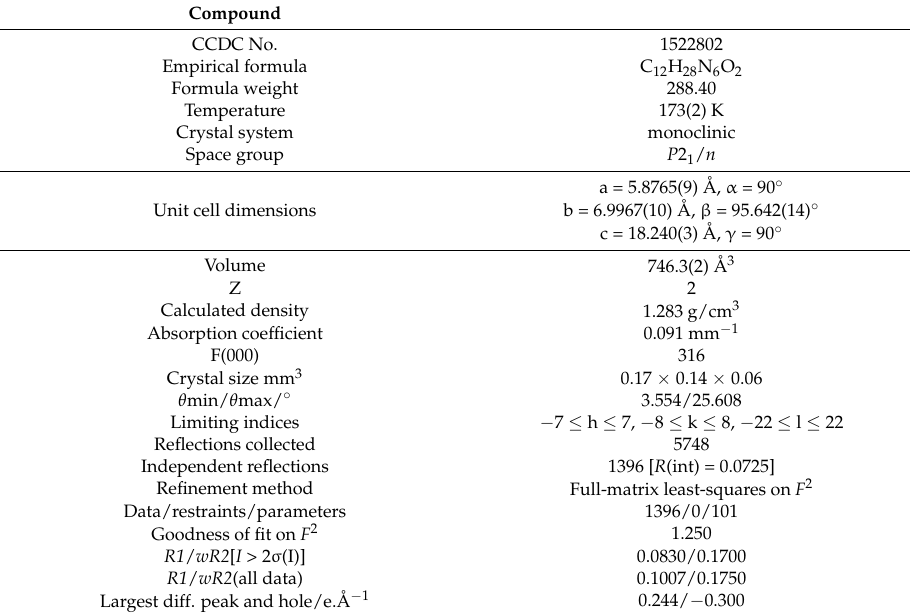
Table 1. Crystal data and structure refinement for ETABOC